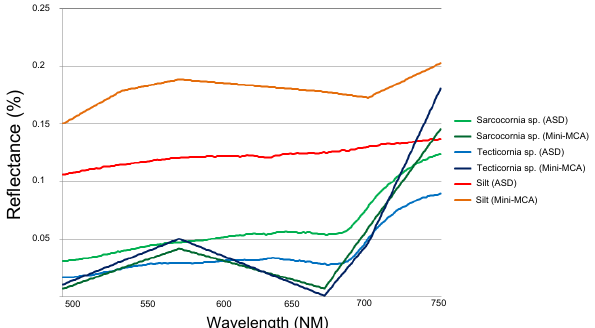
Figure 10: Illustrative Comparison of the Spectral Response of Salt Marsh landcover classes recorded by the ASD spectrometer and the calibrated mini-MCA.